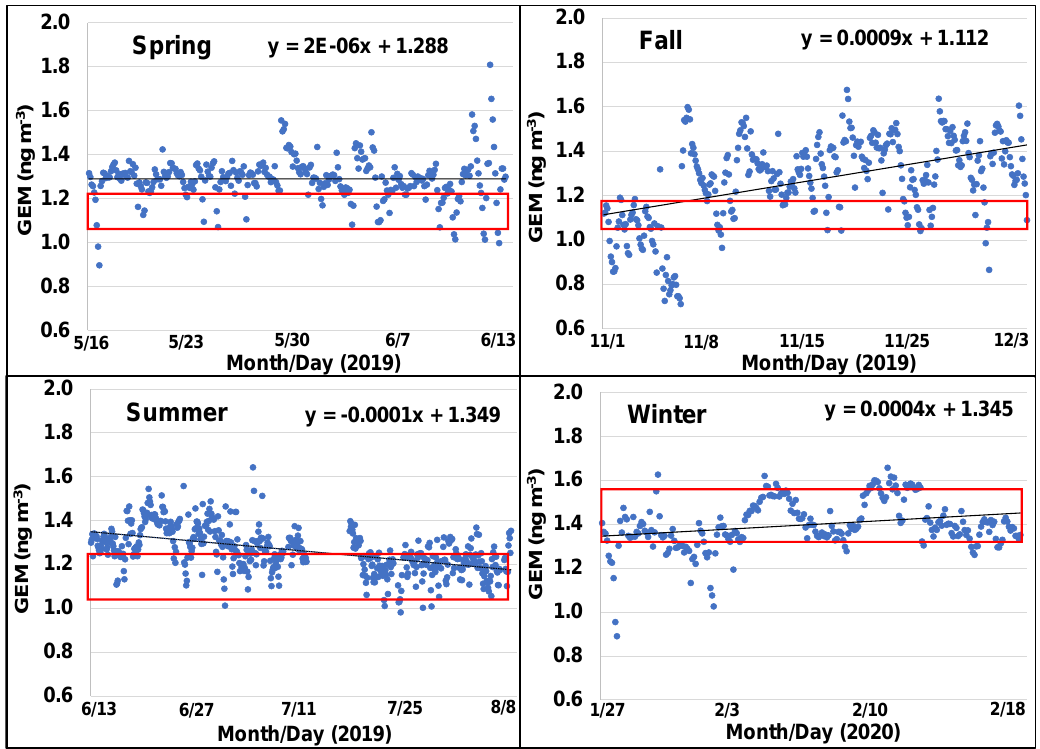
Figure A3. Hourly GEM concentrations determined at the Grand Bay NERR site using active sampling. The red box encompasses the passive sampler data (average ± 1SD) obtained for the same period. The equation is for the linear regression of the data with the trend line in black.